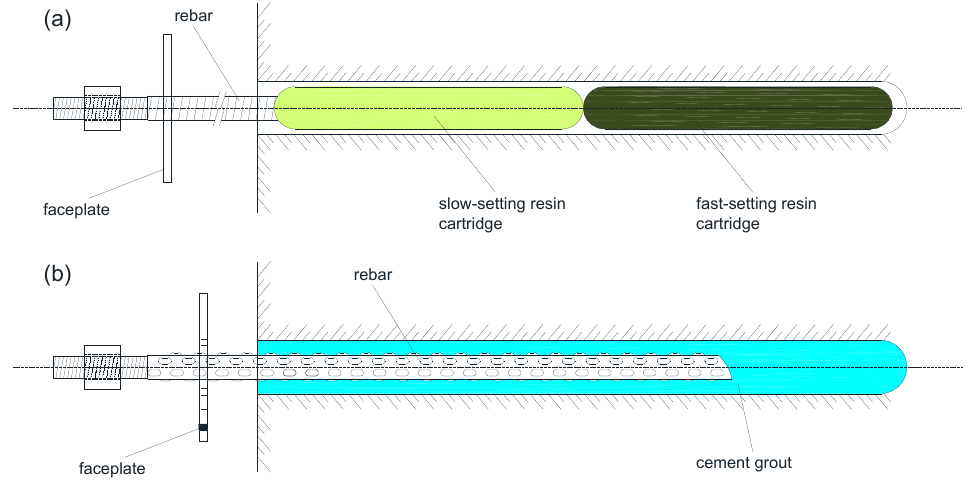
Figure 3. Fully grouted rock bolt: ( a ) fully resin-grouted rock bolt and ( b ) fully cement-grouted rock bolt.